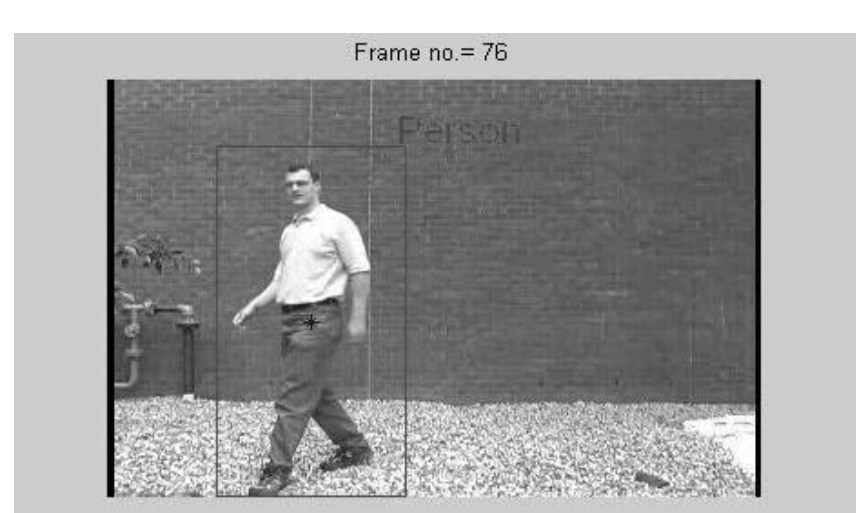
Figure 12. Recognizing object as pedestrian.